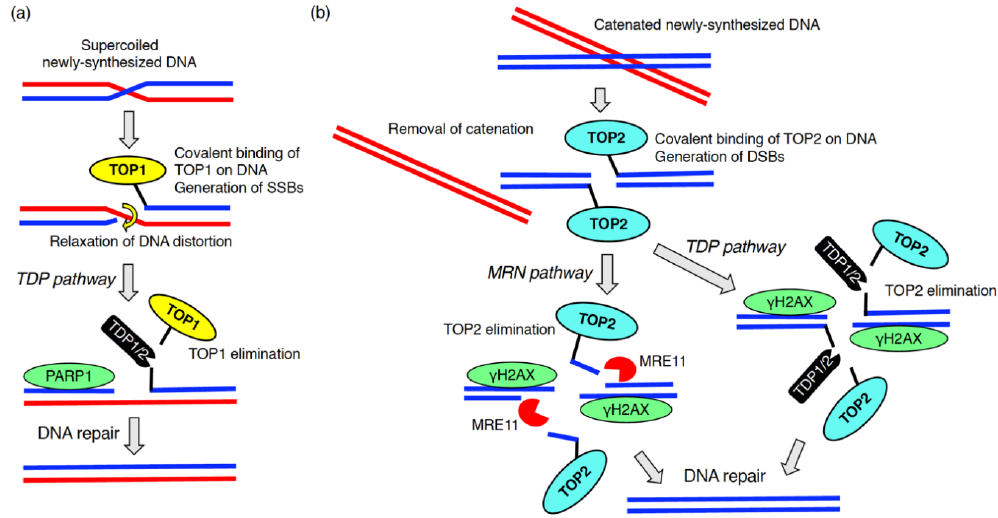
Figure 3. DNA–protein crosslink repair during DNA replication. To solve the topological issue of newly replicated DNA chains, topoisomerase 1 (TOP1) ( a ) or topoisomerase 2 (TOP2) ( b ) are covalently bound to the DNAs. After introduction of DNA breaks followed by the removal of DNA distortion, TOP1 and TOP2 are eliminated by enzymes, tyrosyl-DNA phosphodiesterase (TDP)1, TDP2 or meiotic recombination 11 (MRE11).